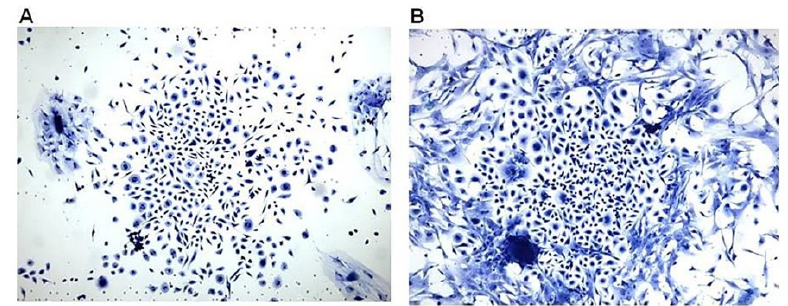
Figure 5. Representative examples of colonies formed within 5 days of culturing cells obtained from PVA sponge discs containing 10 mg/mL α -gal nanoparticles that were implanted subcutaneously for 7 days in GT-KO mice producing anti-Gal. The frequency of colony forming cells was approximately one in 5 × 10 4 and 1 × 10 5 recruited macrophages. The number of cells per colony was ~300 ( A ) and ~1000 ( B ) (×100). Reproduced with permission from ref. [57].